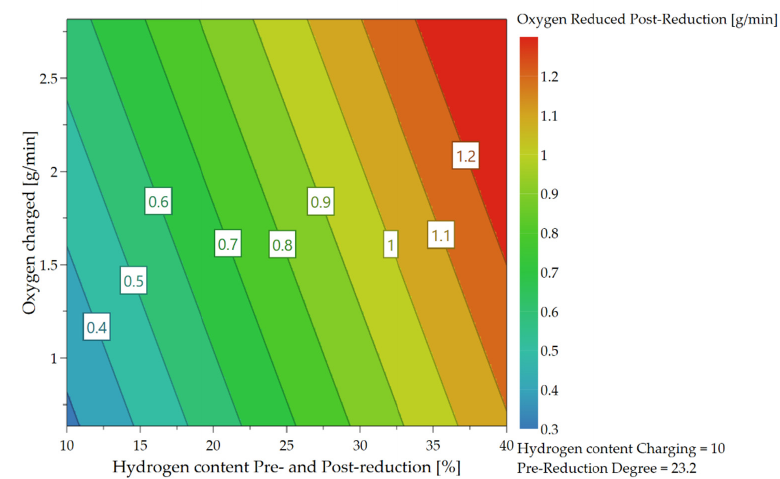
Figure 21. Dependence of the oxygen removal rate during the post-reduction process.